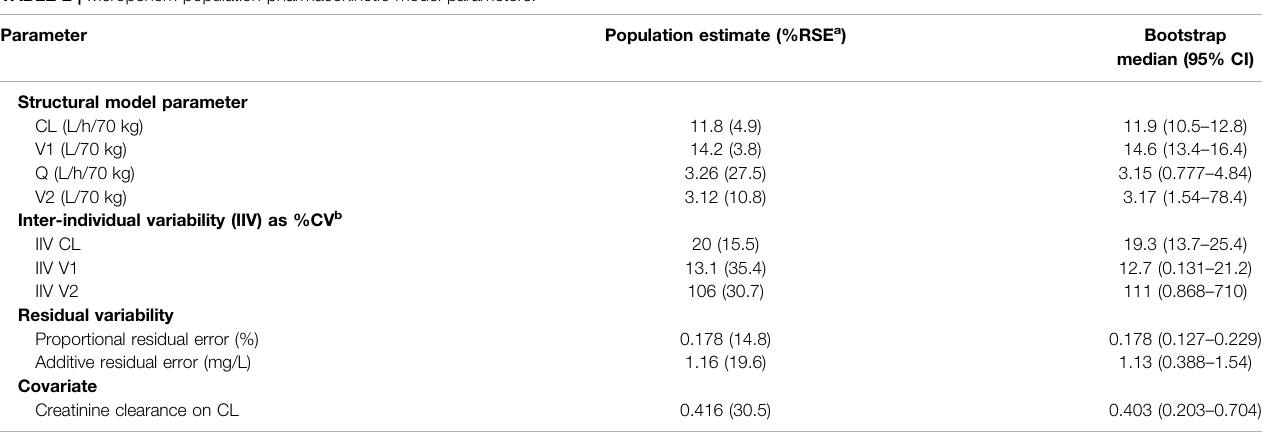
TABLE 2 | Meropenem population pharmacokinetic model parameters.